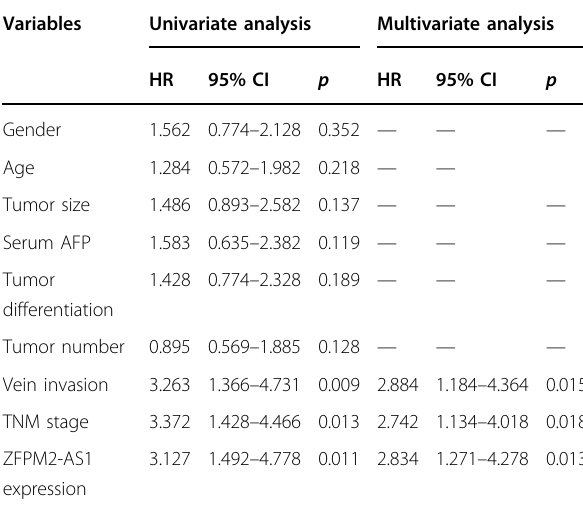
Table 2 Univariate and multivariate analysis of overall survival in HCC